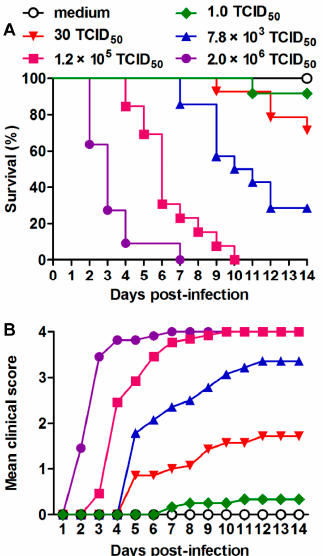
Figure 3. Dose dependence of EVD68-induced disease and mortality. One-day-old ICR mice ( n = 11–